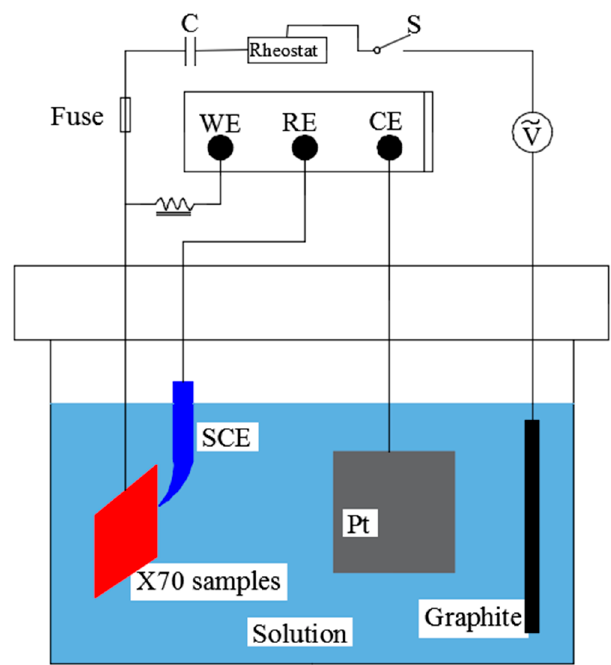
Figure 3. Schematic of the setup for electrochemical measurements.